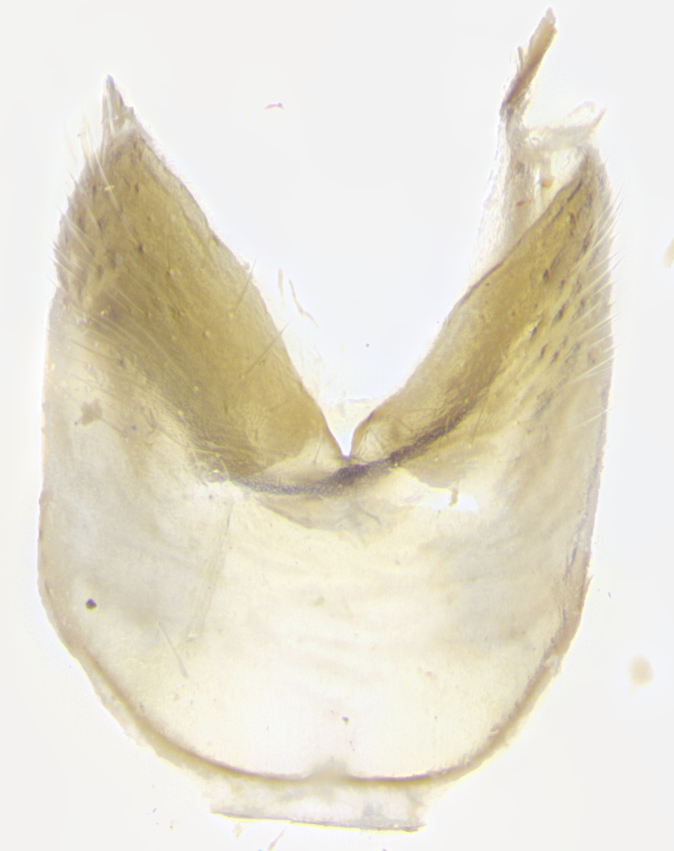
sternite 5, ventral view.